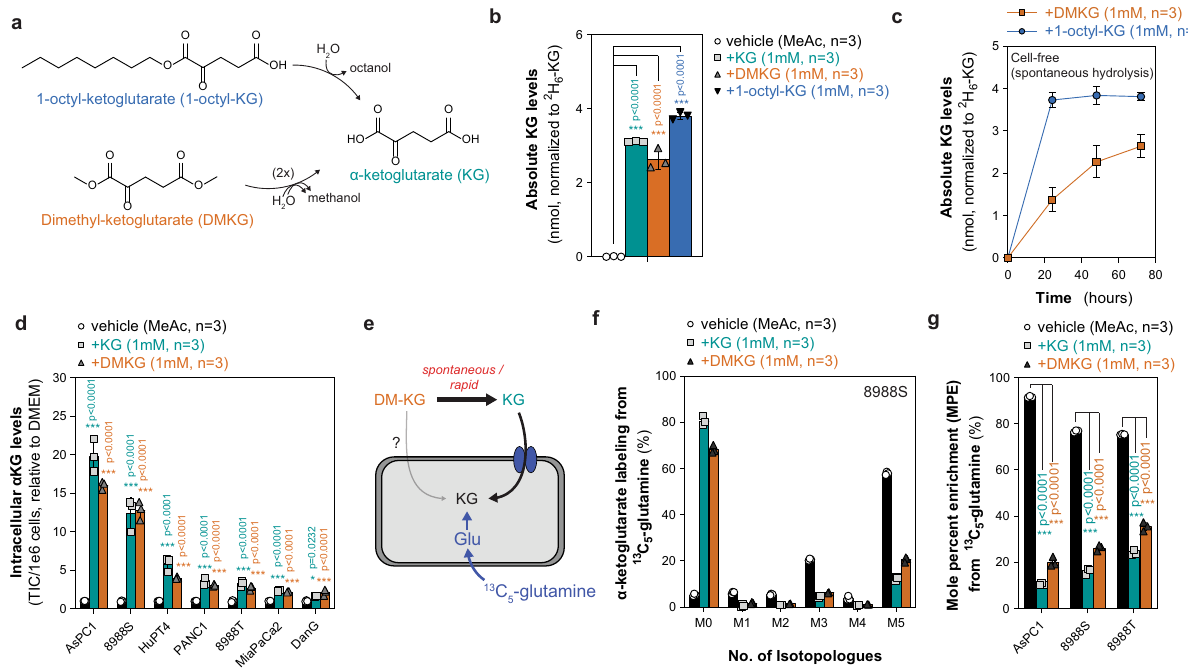
Fig. 1 Spontaneous hydrolysis of α -ketoglutarate esters and equivalent uptake of non-esteri fi ed α -ketoglutarate. a Schematic depicting hydrolysis of dimethyl- α -ketoglutarate (DMKG) and 1-octyl- α -ketoglutarate (1-octyl-KG) to α -ketoglutarate (KG). b Absolute KG levels quanti fi ed after cell-free hydrolysis of 1 mM of DMKG or 1-octyl-KG after 72 h compared to vehicle (methyl acetate; MeAc) and 1 mM KG. Data are mean ± s.d, n = 3 biologically independent experiments; signi fi cance determined by one-way ANOVA using Dunnett ’ s multiple comparisons test, *** p < 0.0001. c Time course of absolute KG levels quanti fi ed after cell-free hydrolysis of DMKG and 1-octyl-KG over 72 h. Data are mean ± s.d., n = 3 biologically independent experiments. d Intracellular KG levels in AsPC1, 8988S, HuPT4, PANC1, 8988T, MiaPaCa2, and DanG cells treated with methyl acetate or 1 mM of KG or DMKG for 24 h. Data are plotted as relative to vehicle-treated condition; mean ± s.d., n = 3 biologically independent samples; signi fi cance determined by two-way ANOVA using Dunnett ’ s multiple comparisons test, * p < 0.05, *** p < 0.0001. e Schematic depicting stable-isotope dilution experiment using 13 C 5 -glutamine to label intracellular KG and quantify KG or DMKG contribution to the intracellular pool of KG. f KG mass isotopologue distribution of 8988S cells labeled with 13 C 5 -glutamine and treated with either methyl acetate or 1 mM of KG or DMKG for 24 h. Data are mean ± s.d., n = 3 biologically independent samples. g Mole percent enrichment (MPE) of intracellular KG labeling of AsPC1, 8988S, and 8988T cells cultured with 13 C 5 -labeled glutamine and treated with methyl acetate or 1 mM of unlabeled ( 12 C) KG or DMKG for 24 h. Data are mean ± s.d., n = 3 biologically independent samples; signi fi cance determined by two-way ANOVA using Dunnett ’ s multiple comparisons test, *** p <